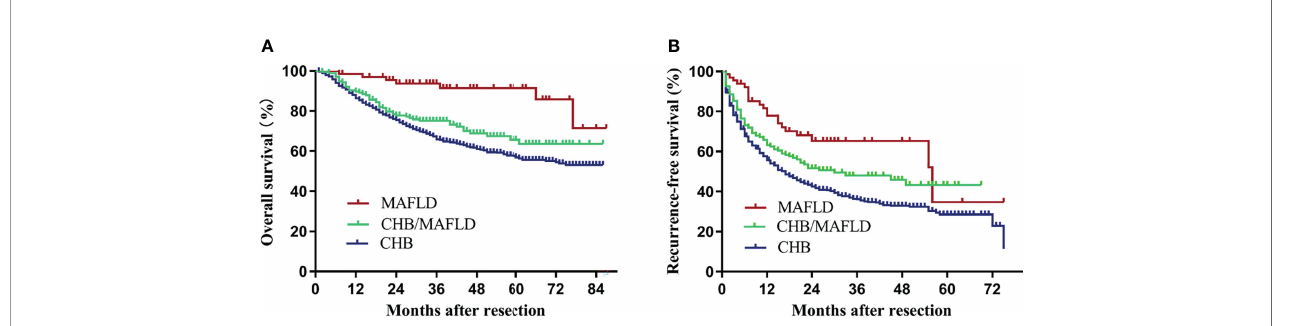
FIGURE 2 | Kaplan – Meier analysis of overall and recurrence-free survival for each counterparts. (A) Overall survival (MAFLD vs CHB, P <0.001; MAFLD vs CHB/ MAFLD, P =0.002; CHB/MAFLD vs CHB, P =0.059), (B) recurrence-free survival (MAFLD vs CHB, P <0.001; MAFLD vs CHB/MAFLD, P =0.038; CHB/MAFLD vs CHB, P =0.010). CHB, chronic hepatitis B; MAFLD, metabolic dysfunction-associated fatty liver disease.